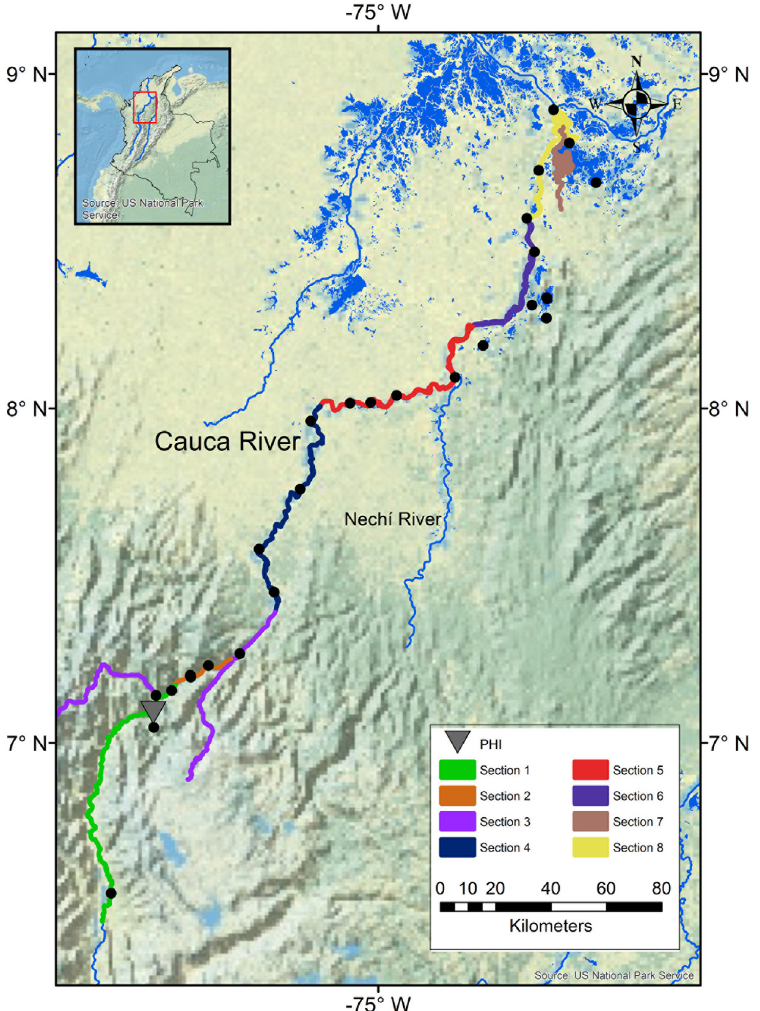
FIGURE 1 | Location of sampling sites of Pimelodus grosskopfii , Sorubim cuspicaudus , and Ageneiosus pardalis in the middle and lower sections of the Cauca River.